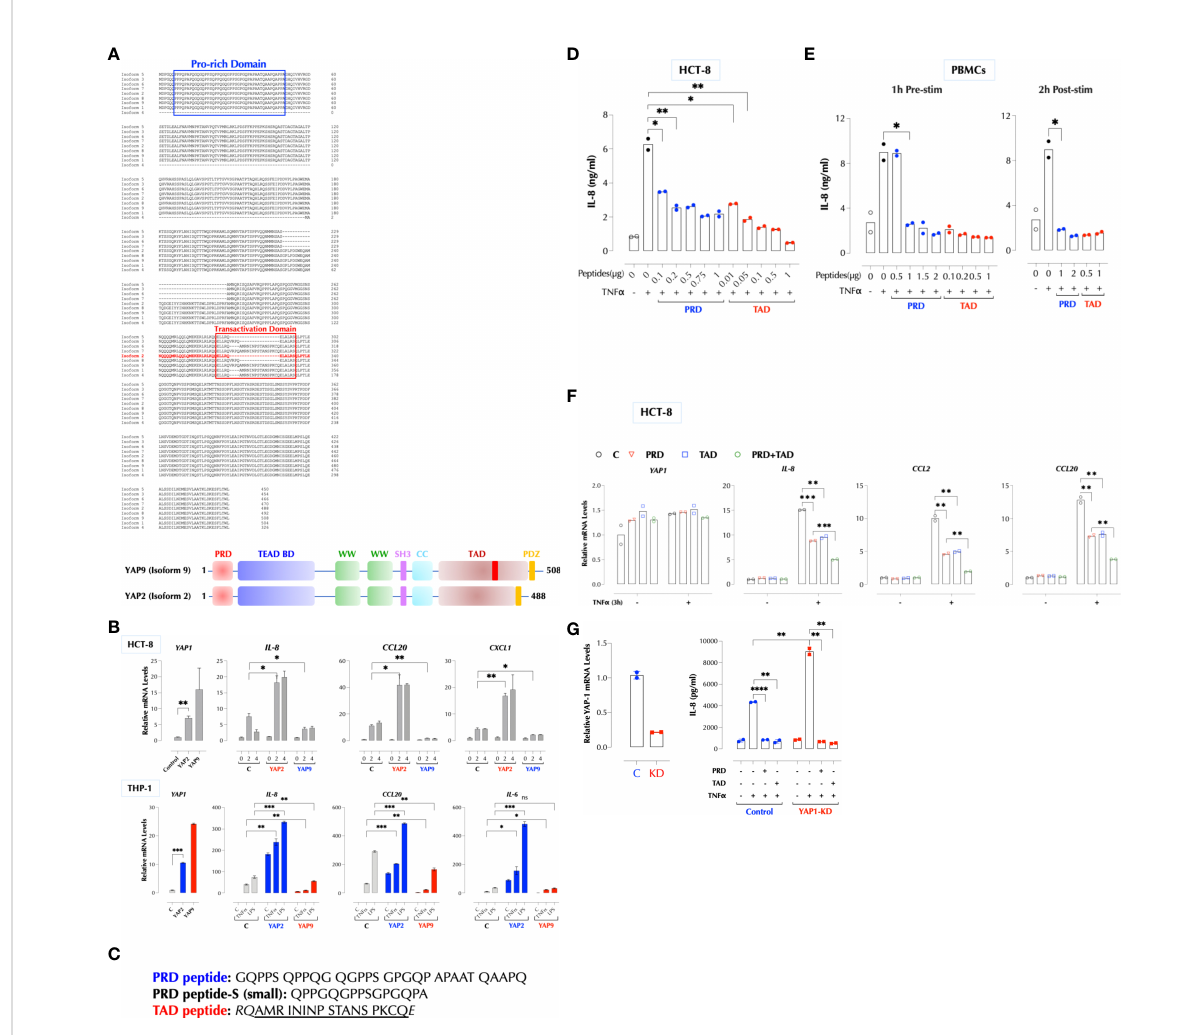
FIGURE 5 YAP1 suppresses the in fl ammatory responses using PRD and TAD. (A) Protein sequence alignment of human YAP1 isoforms. A difference between YAP2 and YAP9 lies within TAD. (B) YAP2 enhances but YAP9 suppresses the in fl ammatory responses. HCT-8 or THP-1 cells (2h stimulation) were transfected with HA-YAP2 or HA-YAP9 and stimulated as indicated and the gene induction levels were measured by qPCR. The results are representatives of 2 or more similar experiments. (C) The sequences of synthetic PRD, PRD-S, and TAD peptides. (D) PRD and TAD peptides inhibit TNF-induced IL-8 expression in a dose-dependent manner. HCT-8 cells were stimulated with TNF a (2ng/ml) with or without the indicated amount of the peptides overnight and IL-8 was measured by ELISA. The results are representatives of 2 or more similar experiments. (E) Human PBMCs were treated with the peptides 1h before or 2h after stimulation with TNF a (1ng/ml) overnight and IL-8 was measured by ELISA. The results are representatives of 2 similar experiments. (F) HCT-8 cells were stimulated with TNF a (2ng/ml) as